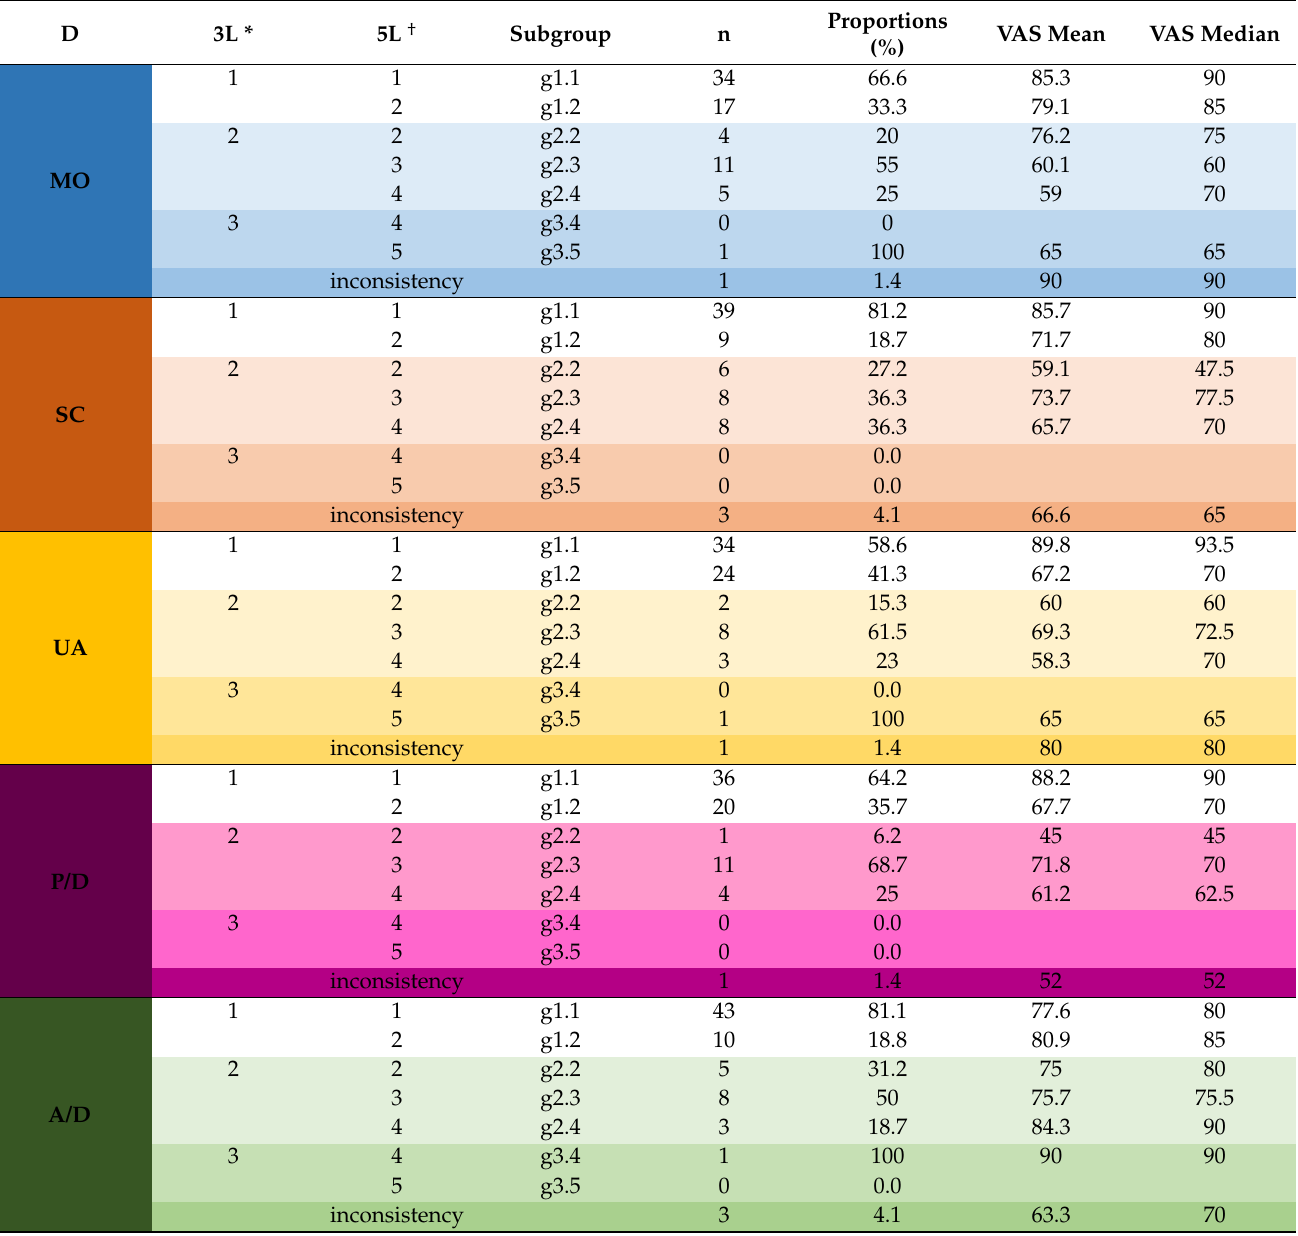
Table 4. Redistribution properties from EQ-5D-Y-3L to